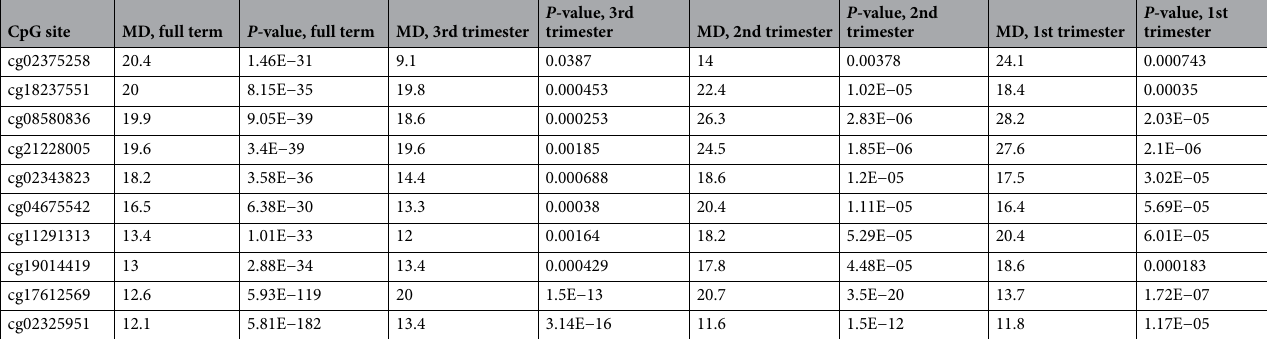
Table 3. Top 10 CpG sites from full term analysis (ranked by absolute value of effect size in full term analysis) displaying persistence across the gestational period. Mean Difference (MD) values calculated as mean in male samples—mean in female